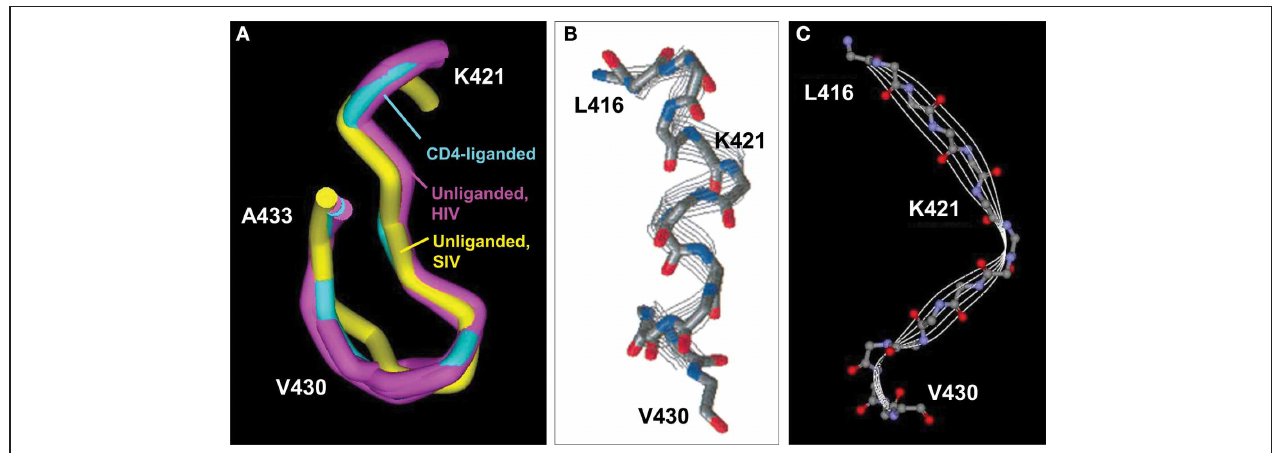
FIGURE 3 | CD4BD core conformations. (A) Superimposed CD4BD core conformations in gp120 variants (residues 421–433) complexed with soluble CD4 and antibody 17b (cyan; 1GC1) and gp120 (extended core) without a ligand (purple; 3TGQ, 3TGR, 3TGT, 3TIH). For comparison, the CD4BD core of unliganded SIV gp120 is included (yellow; 2BF1). Protein backbones were superimposed onto the CD4-bound structure. (B) Structure of a synthetic